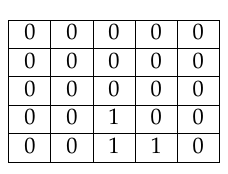
Table 13. Boolean vector from Table 12 transformed to a matrix to be easily mapped to the cells of the RoI.